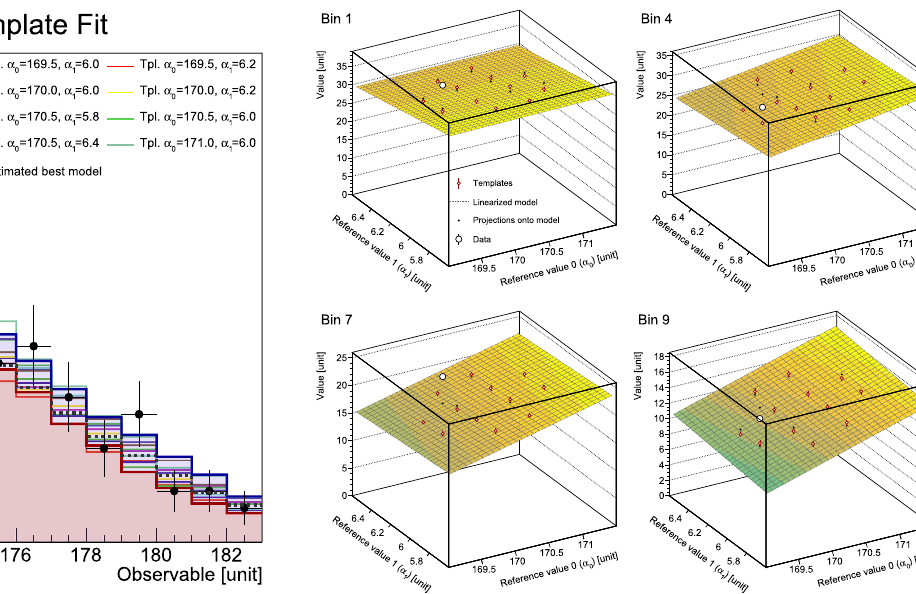
as a function of the two reference values for four selected “bins” i . The plane displays the linearized model ˆ y i ( α ) , Eq. (27), in the respective bin. The large open circles are again the pseudo-data, and small circles indicate the projection onto the plane ˆ y